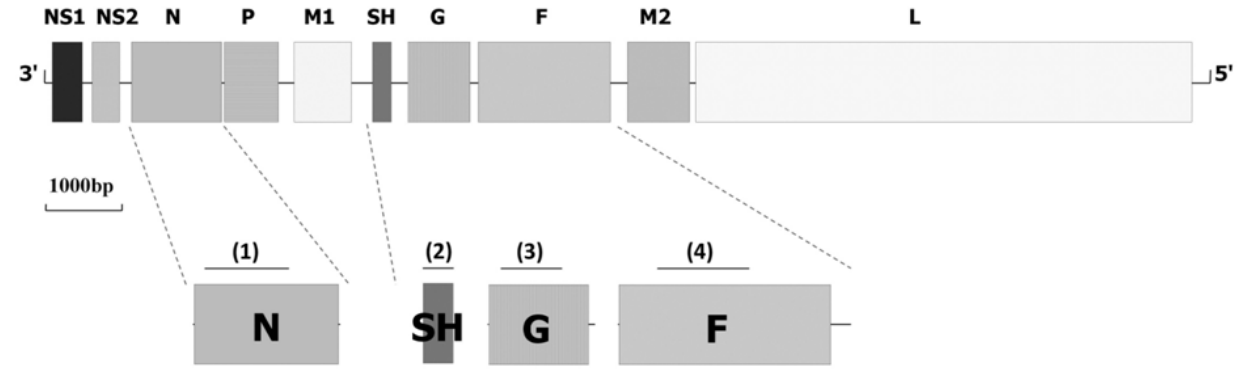
Figure 1. Bovine respiratory syncytial virus ( BRSV) genome scheme and commonly used region for molecular epidemiology studies. The areas encoding the BRSV proteins are represented in boxes. Targeting regions are following: region (1), N region (nt 1294 to nt 1984); region (2), SH complete genome (nt 4268 to 4513); region (3), G region (nt 4864 to 5353); region (3), F region (nt 6071 to nt 6812). Nucleotide positions were given in reference to strain